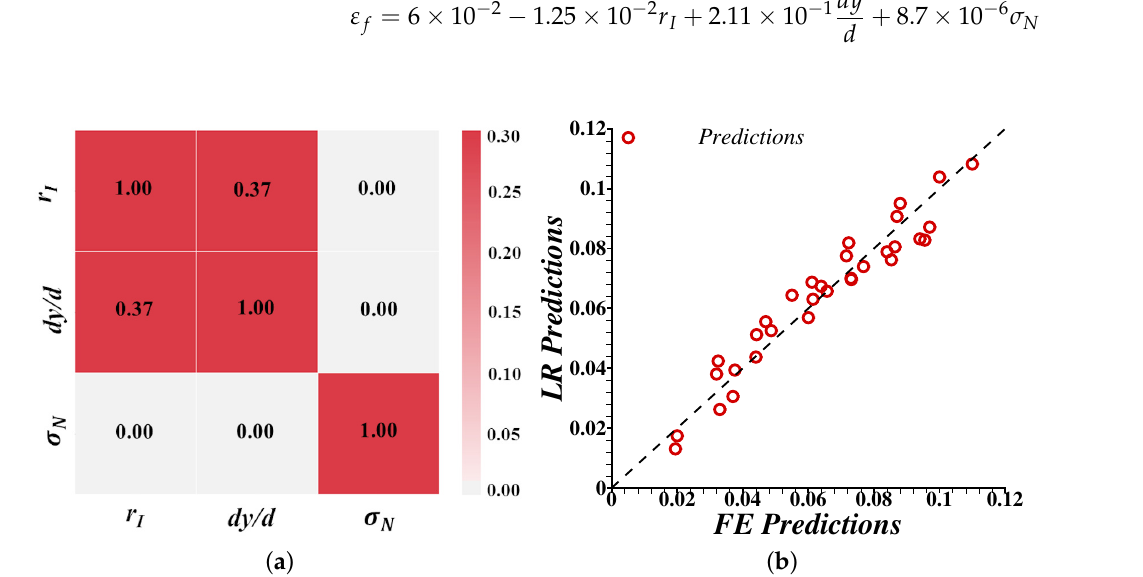
Figure 10. ( a ) Correlation matrix of variables in analyzing the effect of an inclusion on the bendability of the single-phase material. ( b ) Comparison of the macroscopic flexural strain to failure, ε f , predicted using linear regression ( LR ) analysis and microstructure-based finite element ( FE )